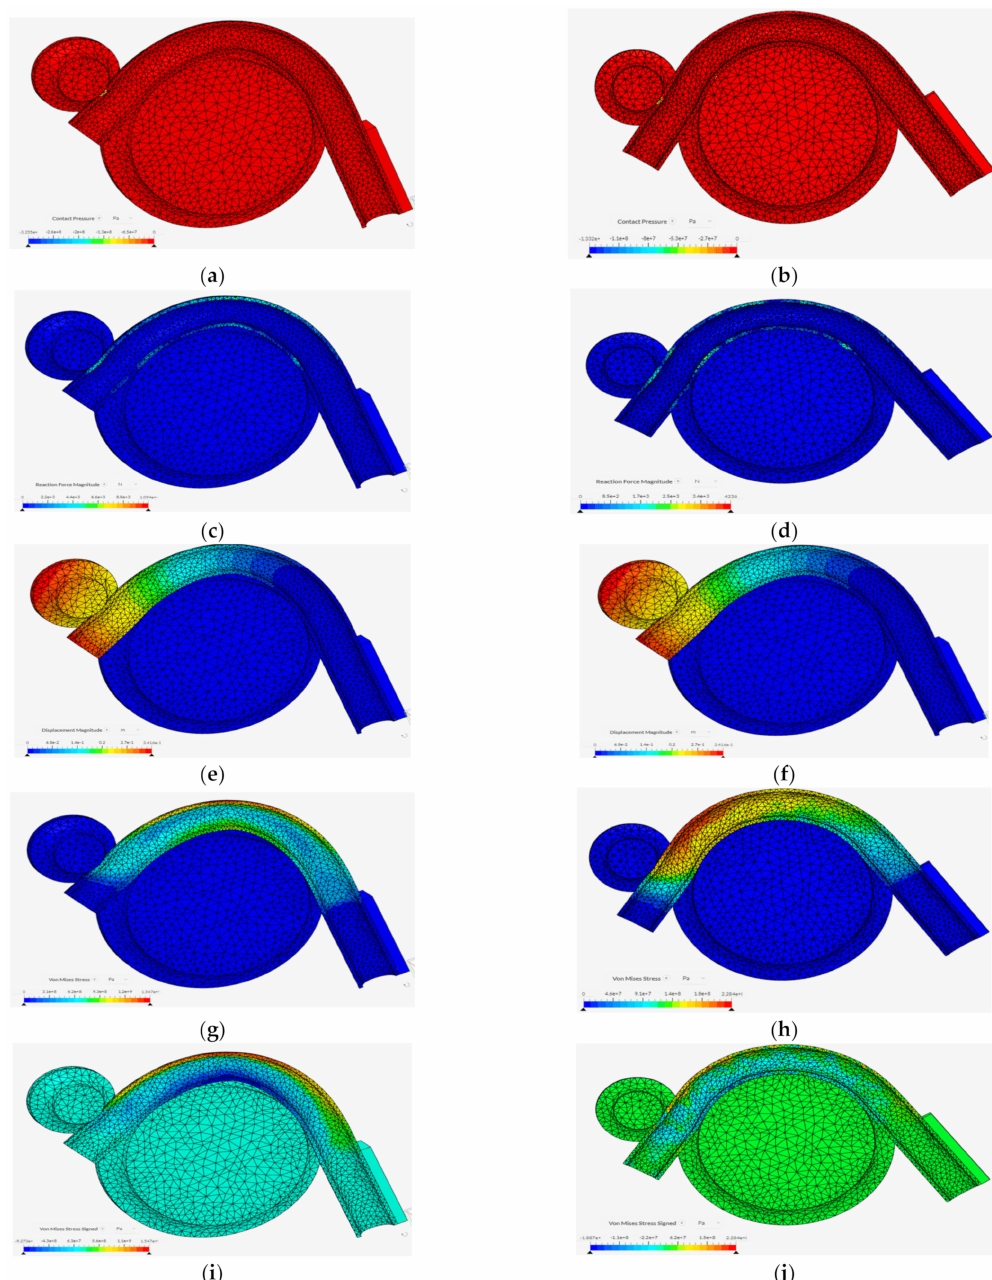
Figure 13. Contour plots of the reeling hose showing the reaction force, contact pressure, deformation and Von Mises stress from tensioner and reeling hose model, and the material is a Nylon PA66-GF com- posite reeled pipe on a steel drum. ( a ) Contact Pressure for linear elastic model, ( b ) Contact Pressure for elastoplastic model, ( c ) Reaction force for linear elastic model, ( d ) Reaction force for elastoplastic model, ( e ). Deformation for linear elastic model, ( f ) Deformation for elastoplastic model, ( g ) Von Mises profile for linear elastic model, ( h ) Von Mises profile for elastoplastic model, ( i ) VonMises (signed) profile for linear elastic model and ( j ) Von Mises (signed) profile for elastoplastic